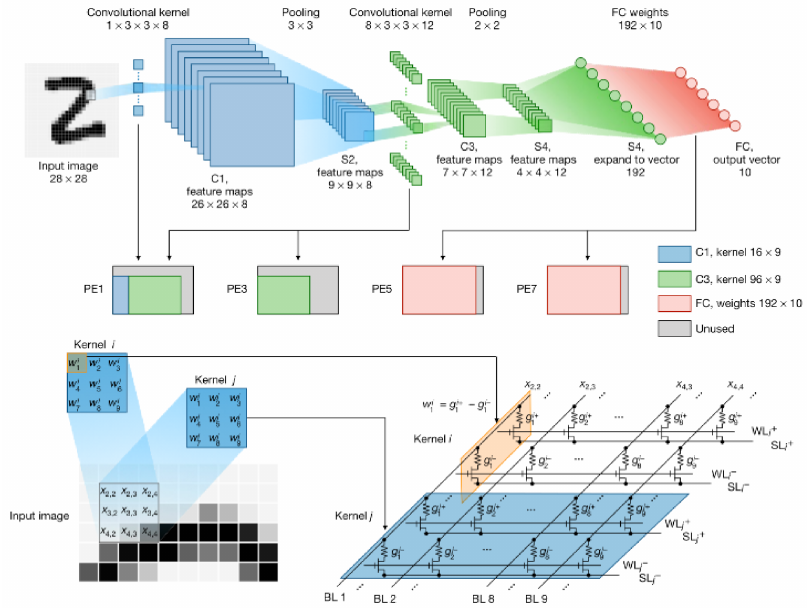
Figure 12. Five-layer mCNN with memristor